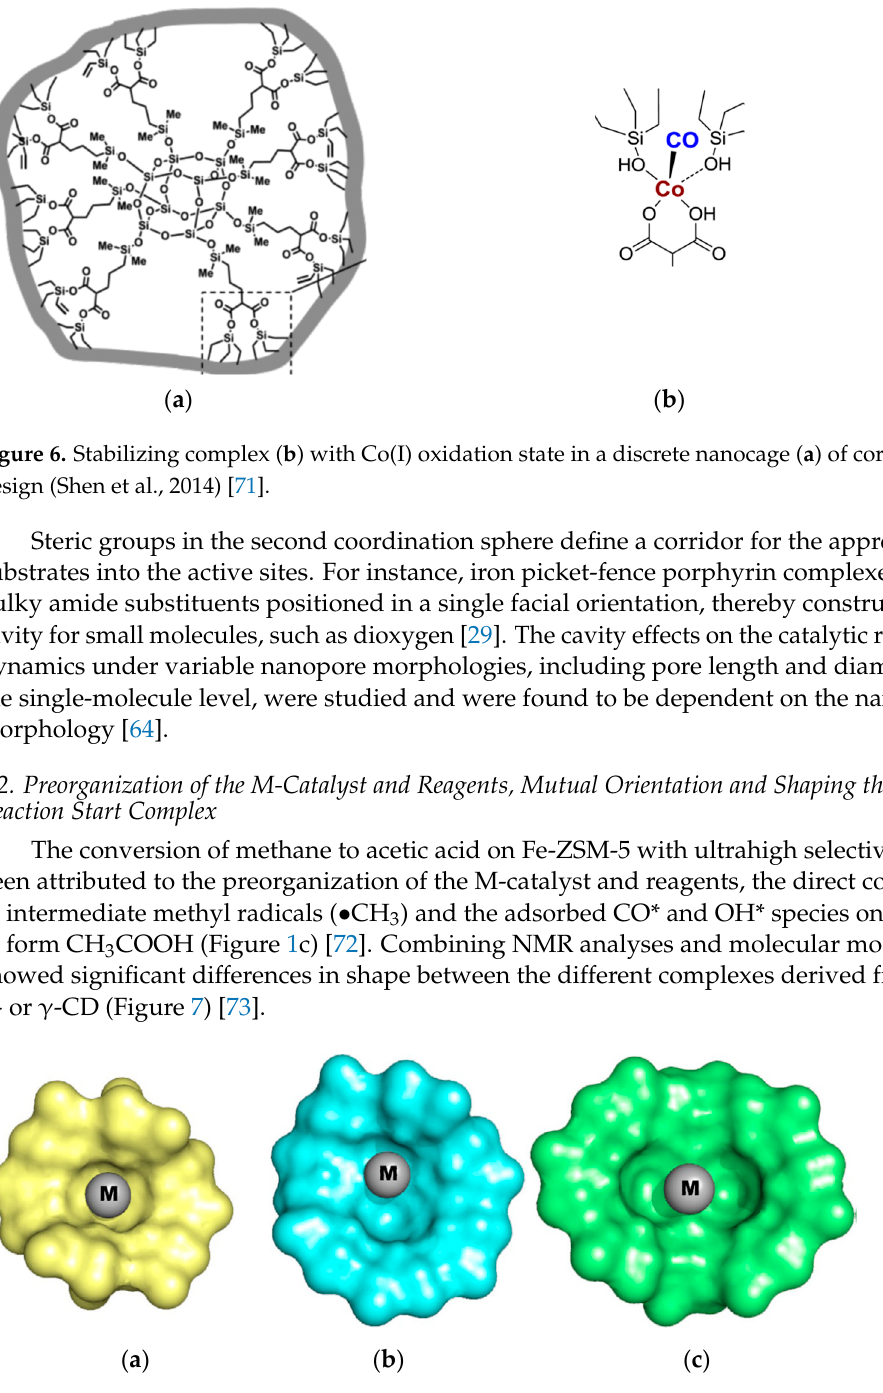
Figure 7. 3D structures of hybrid cyclodextrin–imidazolium M-cavitins: ( a ) α -ICD, ( b ) β -ICD and ( c ) γ -ICD. Reprinted with permission from (Roland et al., 2018) [74]. Copyright 2018